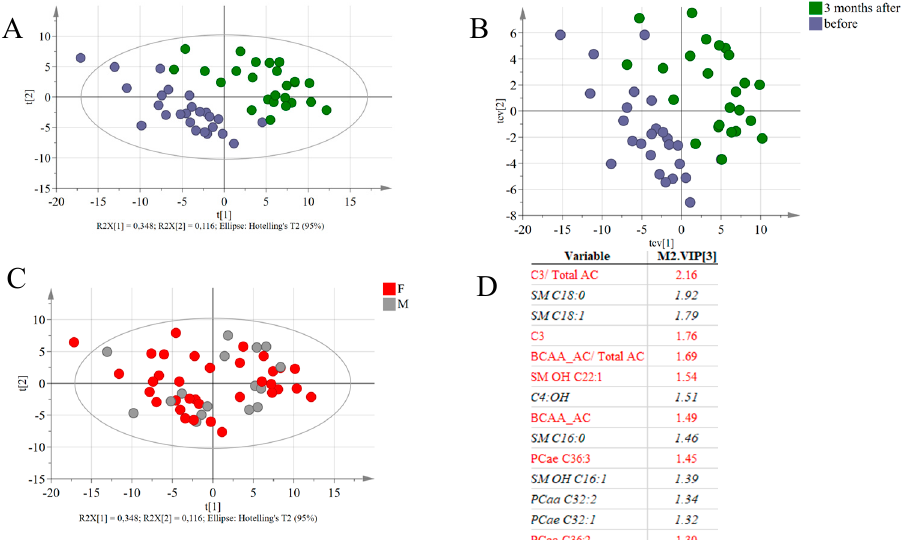
Figure 4. ( A ) Score plots of PLS-DA based on 143 identified lipid species from all patients before and 3 months after the surgery. ( B ) Cross-validation score plots, indicating that even after cross validation, the separation between the two groups of samples is still observed. ( C ) Score plots of the PLS-DA model, coloring the subjects according to gender. ( D ) List of variable with the highest VIP values. Variables in red are associated with samples collected before the intervention and variables in black and italic had higher concentrations in the samples collected 90 days after the intervention.